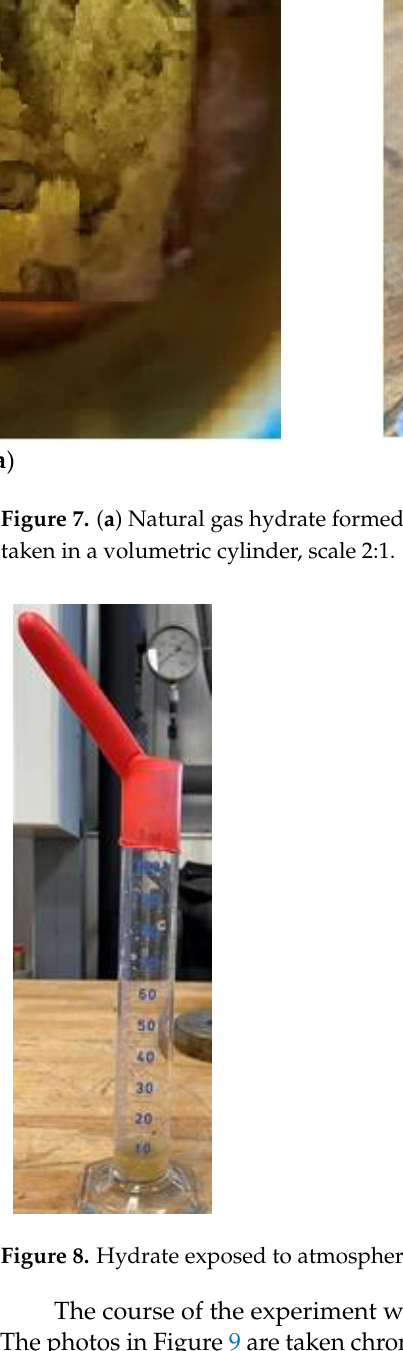
Figure 9. Images of the sapphire visor on VN2 during the experiment, scale 1:1. 6. Discussion and Conclusions The obtained knowledge on the rapid generation of natural gas confirmed that it is possible to find a technological process that can generate natural gas hydrates in orders of magnitude shorter times compared to the classical methods of generating natural gas hydrates in autoclaves by water saturation only. While without mixing of water and gas it takes up to several hours to generate hydrates, our proposed and tested method of gen- erating hydrates has times in the order of minutes. Hydrates of natural gas or methane have interesting potential, and therefore the fu- ture need for energy originating from hydrocarbon sources may be a requirement for im- proving synthetic hydrate formation processes. A promising option is to accumulate standard natural gas in the form of artificially formed hydrates, with subsequent storage and, in cases of need to cover energy peaks, future release. Gas storage in this form is